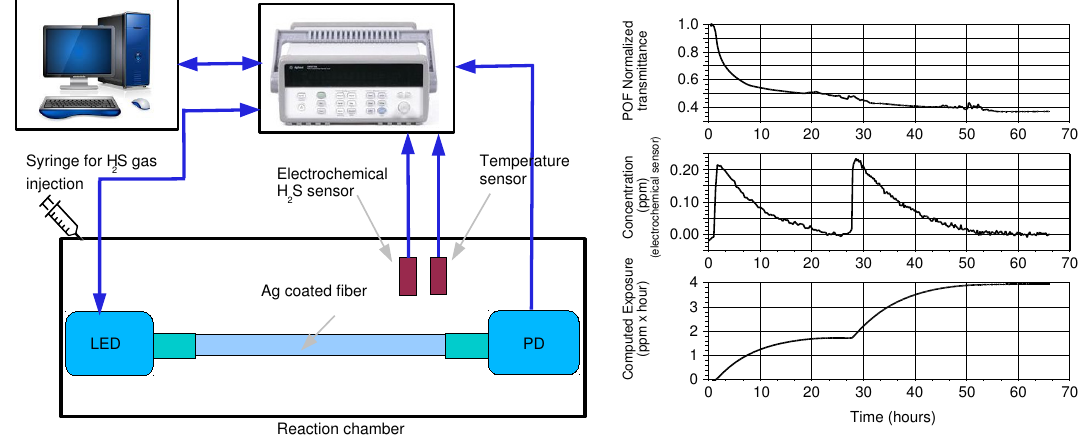
S sensor ( left ) and an example of traces 2